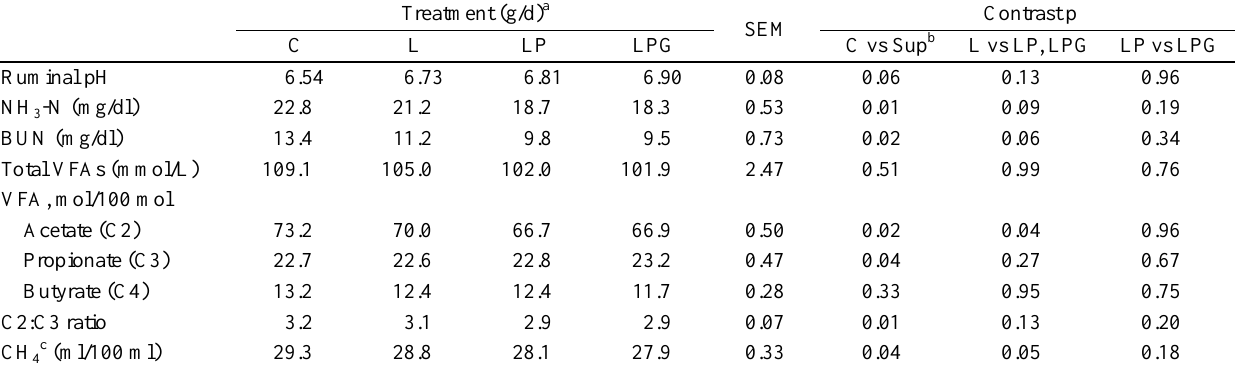
Table 2. Influence of lemongrass, peppermint and garlic supplementation on ruminal pH, blood urea N and rumen fermentation characteristics in